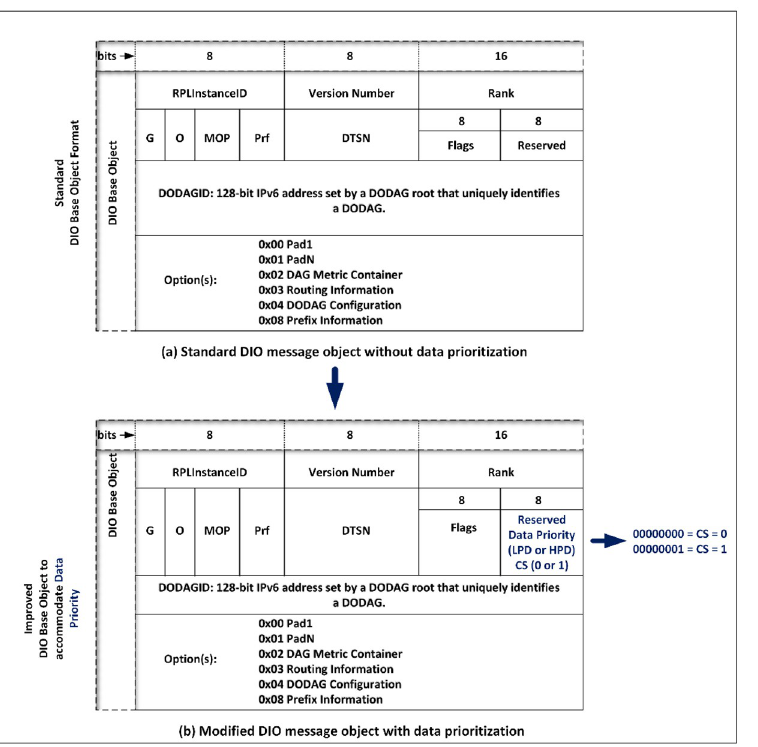
Fig 7. (a) Standard DIO base object (b) Modified DIO base object.